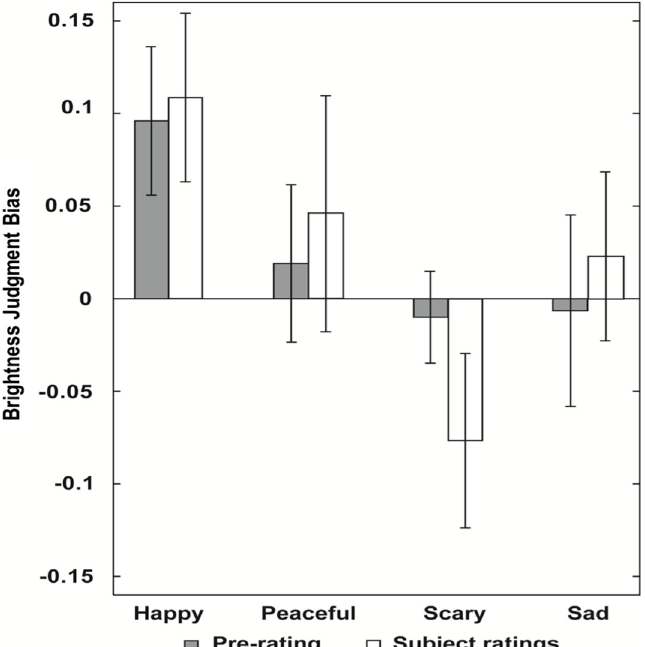
Fig 1. Results of Experiment 1. Brightness judgment biases, separately for happy, peaceful, scary, and sad excerpts. Excerpts were categorized based on the objective intended emotion after [26] or based on the subjective ratings of each participant. Error bars indicate SE of the